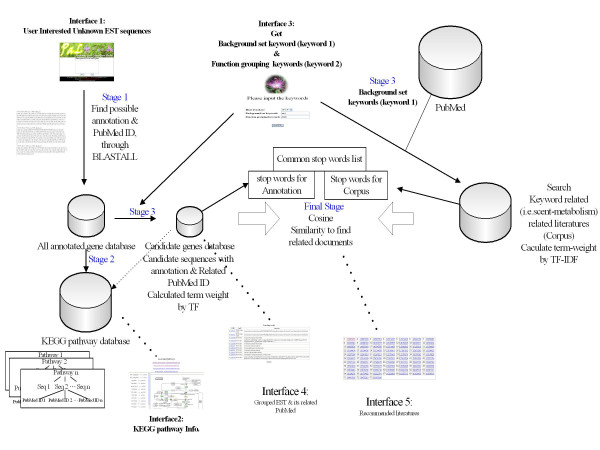
The flowchart of PaL finder.